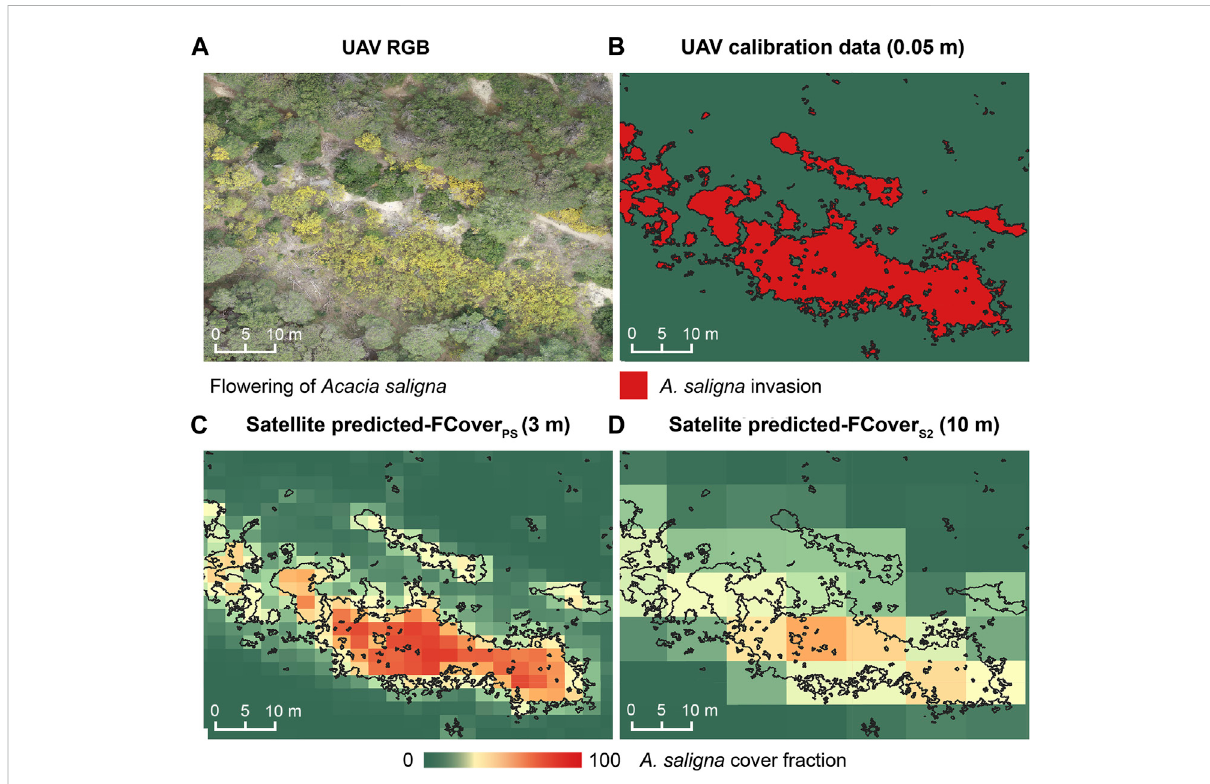
FIGURE 4 Visualexampleof (A) UAVorthophotographscapturedduringthe A.saligna fl oweringperiod, (B) calibrationdataderivedbytheUAV-basedVHR A. saligna map 0.05 m, (C) A. saligna fractional cover on the PlanetScope model (predicted-FCoverPS), and (D) A. saligna fractional cover on the Sentinel-2 model (predicted-FCoverS2). Black edges reported on boxes C and D depict the shape of UAV-based A. saligna distribution used as calibration